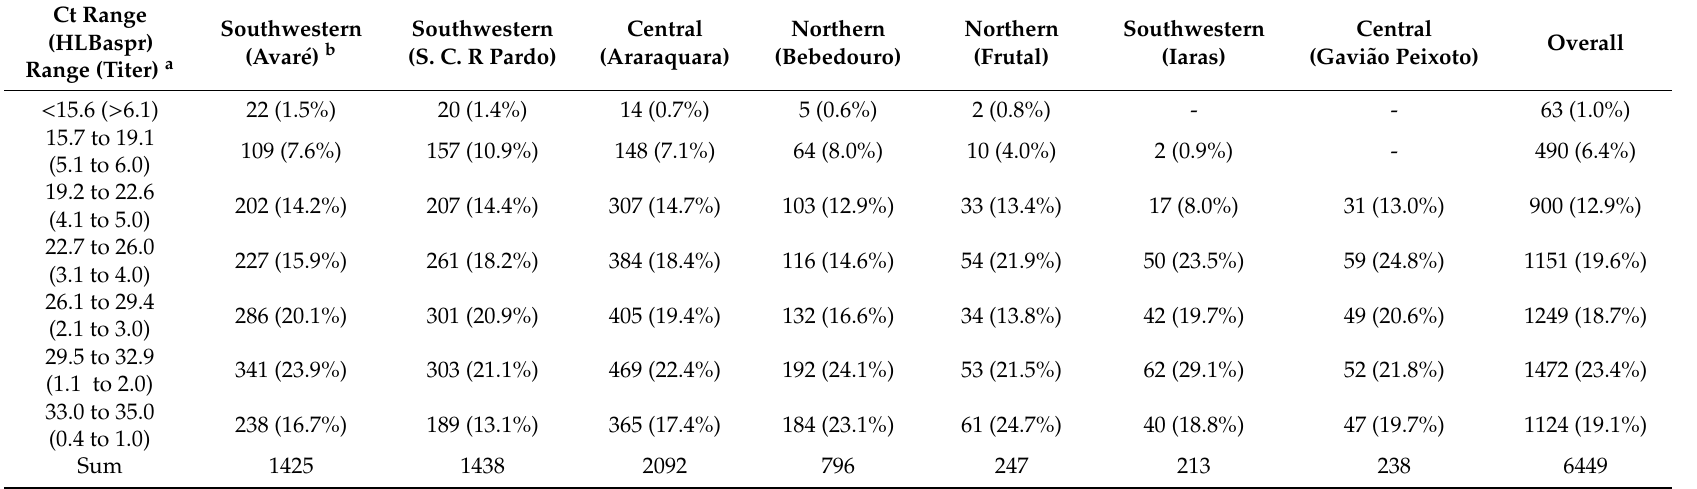
Table 2. Titer of Candidatus Liberibacter asiaticus in individual adult psyllids ( Diaphorina citri ) sampled in yellow sticky traps as determined by qPCR in relation to sampled